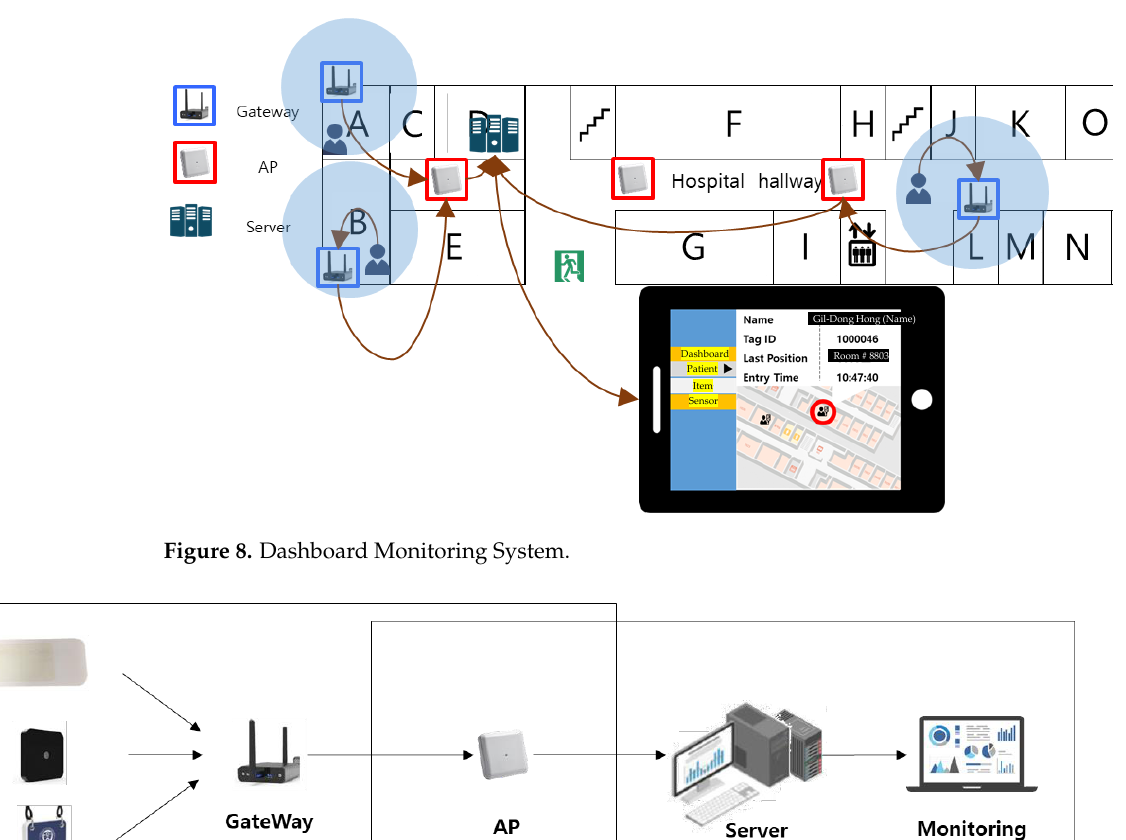
Figure 8. Dashboard Monitoring System.